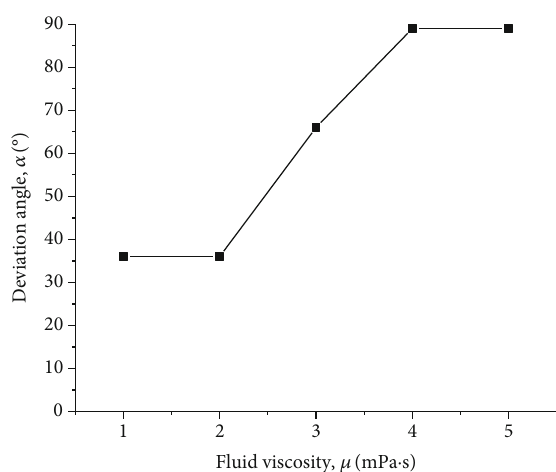
Figure 16: Variation of the maximum deviation angle for di ff erent fl uid Figure 22(c). The fl uid pressure varied slightly compared with type A. The induced shear slip on the horizontal NFs was similar between types A and B. Additionally, the vertical NFs connected by the HF appeared to be fully activated by shear failure. Most of the other vertical NFs also underwent a slight slip. In general, the HF propagation was similar between types A and B.